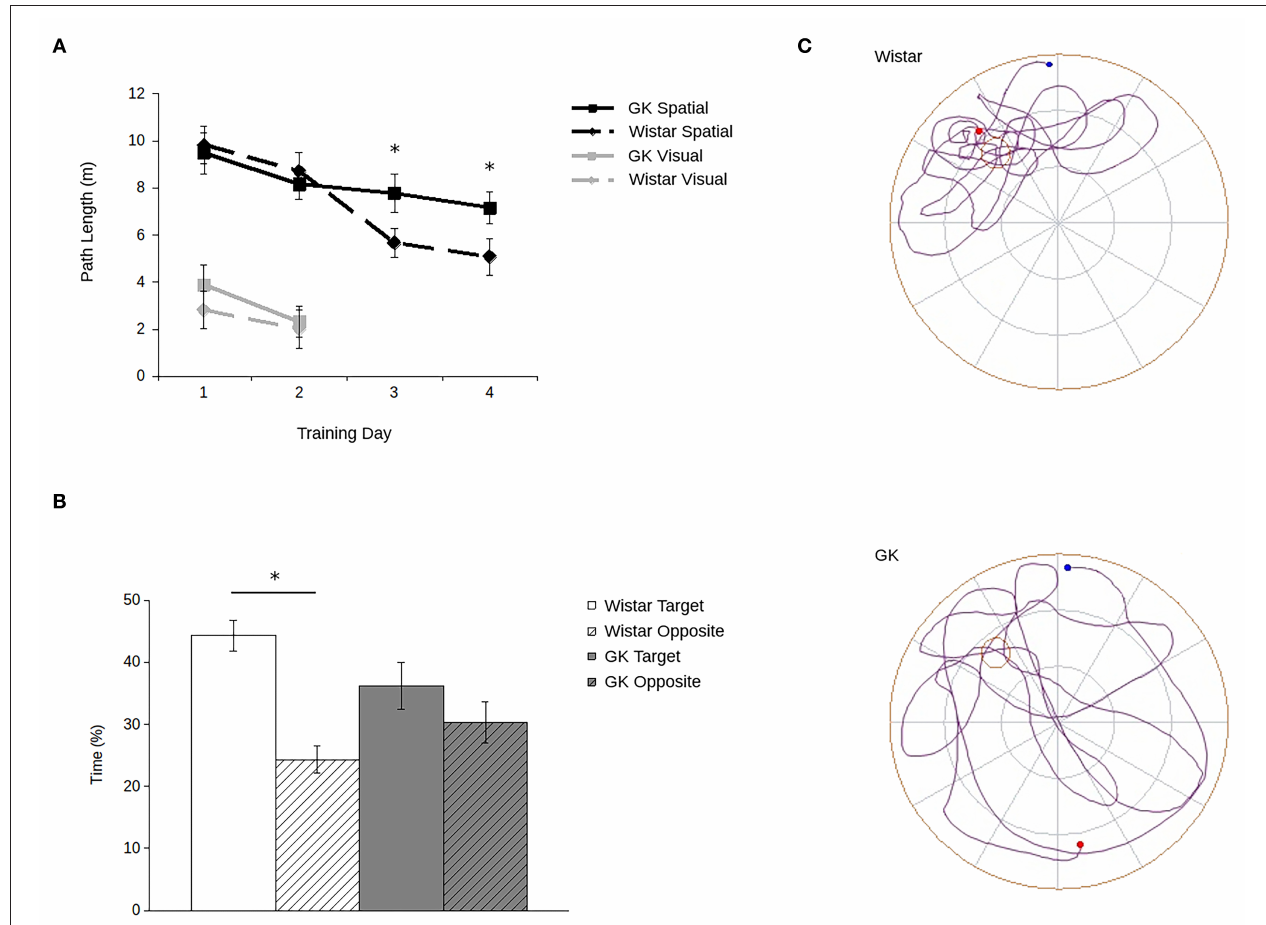
FIGURE 2 | Goto-Kakizaki (GK) rats show impaired spatial reference memory in the Morris water maze. Path lengths (A) show that GK rats (square) swam longer paths to reach the hidden platform (black lines) than did the age-matched Wistar rats (diamond). When the platform was visible (gray lines), GKs and Wistars had comparable path lengths. During probe trials (B) with the platform removed, Wistars (white), but not GKs (gray) spent more time in the maze quadrant that previously contained the platform (blank) compared to the opposite quadrant (hatched). Representative path lengths (C) during the probe trial confirm that during probe trials, Wistar rats (above) swim from their start point (blue) to the platform’s quadrant and swim a more confined pattern with an end point (red) adjacent to the platform’s previous location. GK rats (below) swim through a greater proportion of the maze and at a greater distance from the platform’s previous location (all data are mean ± SEM; * p < 0.05, GK vs.